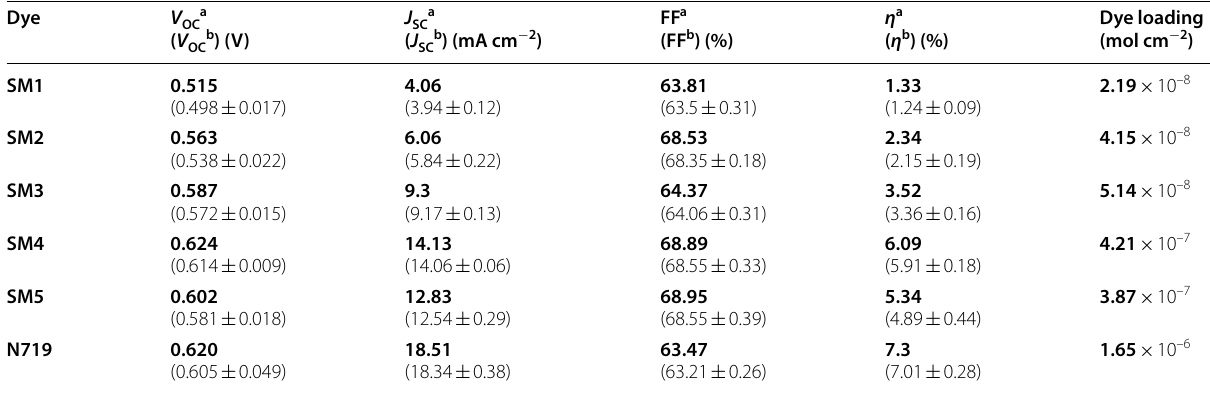
V OC : the open circuit voltage, J SC : the short current density, FF : the fill factor, and η: the efficiency a The best device parameters (listed in the manuscript) b The average device parameters (obtained from four devices)